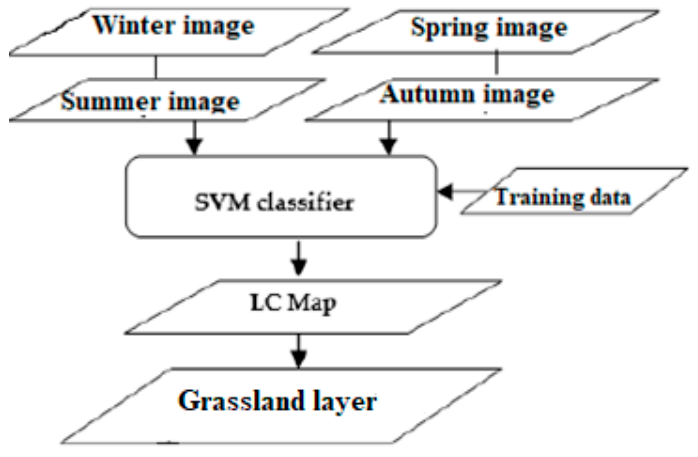
Figure 3. Workflow for the grasslands cover mapping, for each